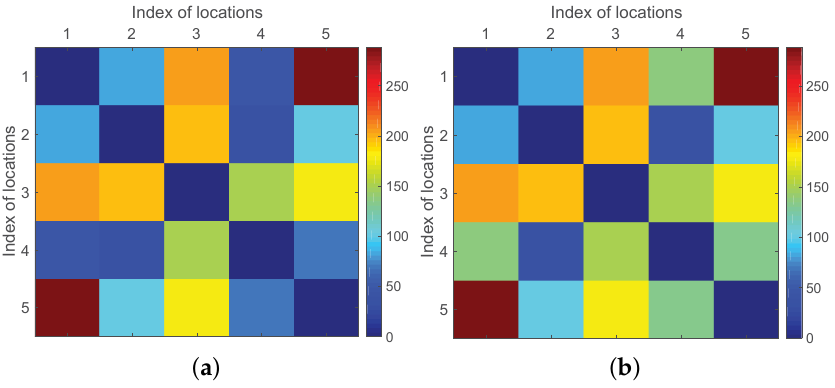
Figure 7. Heat map of pedestrian flow matrix: ( a ) The original matrix; ( b ) The changed matrix. In Figure 8b, the similarity between the predicted matrix by the ABMF and the ground truth matrix is higher than that of the other three algorithms overall. Regarding the metric of similarity, its range is 0 to 1, and the greater the similarity, the closer the predicted result is to the ground truth. As the ABMF takes into account the entire flow sources of a route with a business event, the ABMF is utilized for pedestrian flow prediction with the diversity of business events set. The result shows that the ABMF outperforms vSVR, PMF, and MOHER, because the three methods fuse the influence of business in the model, while ABMF models the attraction of business events to the pedestrian flow in the design. MOHER performs better than vSVR and PMF because MOHER uses LSTM to mix different flow modes and then predict the pedestrian flow. The performance of MOHER is not as good as ABMF, because MOHER is more suitable for the mix of different transportation modes, and only predicting pedestrian flow can not play a full role. In Figure 9, ABMF performs well on large-scale real datasets, and its performance is superior to vSVR, PMF, and MOHER. The analysis in Figure 9 with the Foursquare dataset is consistent with that in Figure 8.